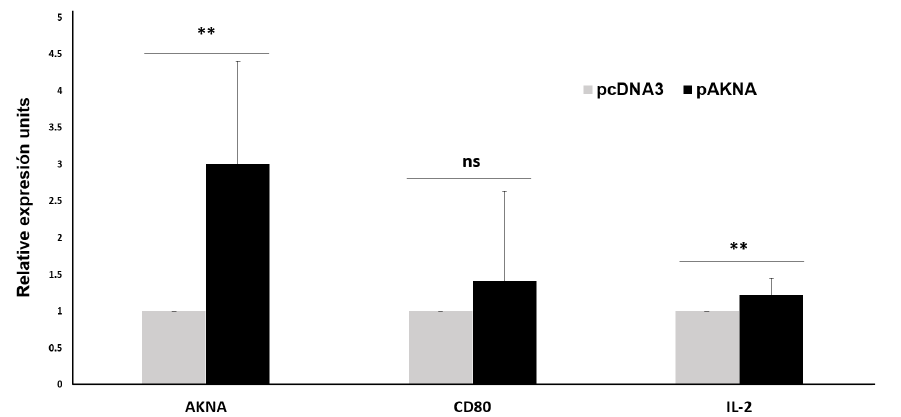
Figure 6. Experimental validation of CD80 and IL-2 expression in Jurkat cells transfected with akna . CD80 , akna and IL-2 gene expression levels were measured in Jurkat cells transfected with pcDNA3- akna or pcDNA3 plasmids for 24 h. We observed an IL-2 gene expression compared to the empty plasmid, as well as a trend of increased expression of CD80 although this did not reach statistical significance. The graph shows the average result from three independent experiments. ns: non-statistically significant, ** p < 0.05.